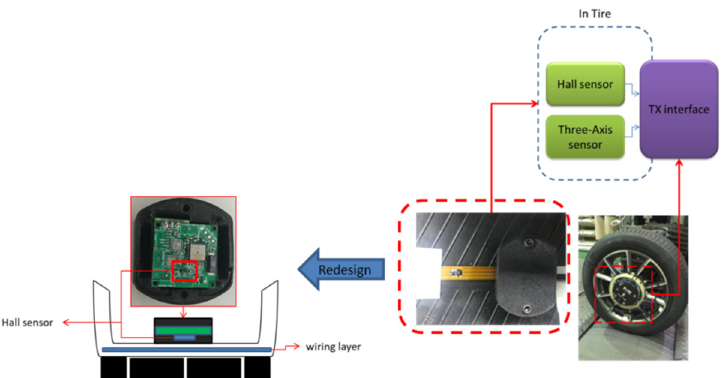
Figure 2. System implementation. Figure 2. System